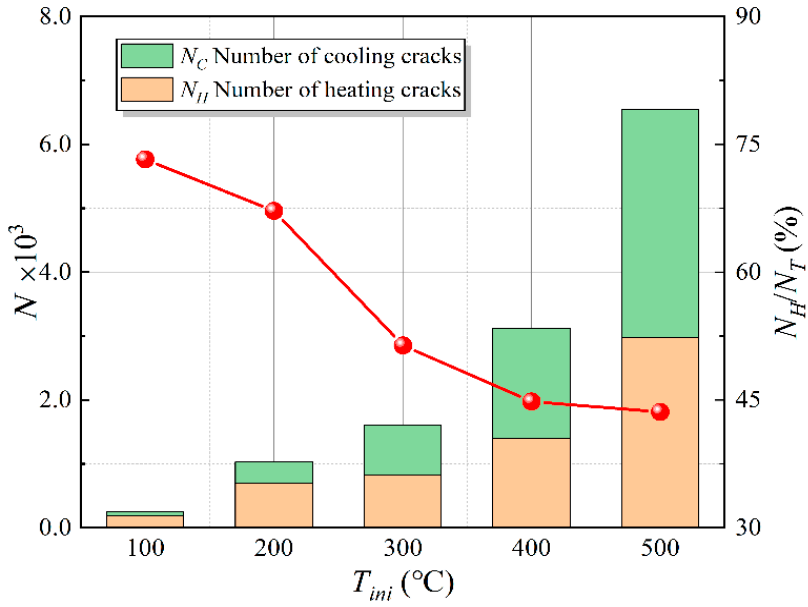
Figure 11. Comparison of the number of the heating cracks and the cooling cracks.